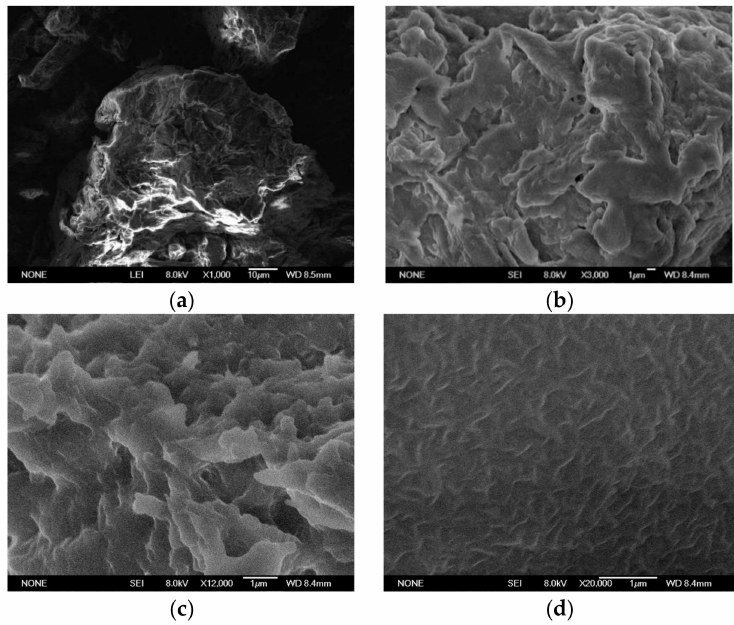
Figure 3. Dissolution of cellulose in oxalic acid-chlorocholine. DES: ( a ) The SEM of cellulose before dissolving; ( b ) cellulose SEM after reaction 30 min; ( c ) cellulose SEM after reaction 60 min; ( d ) cellulose SEM after reaction 90